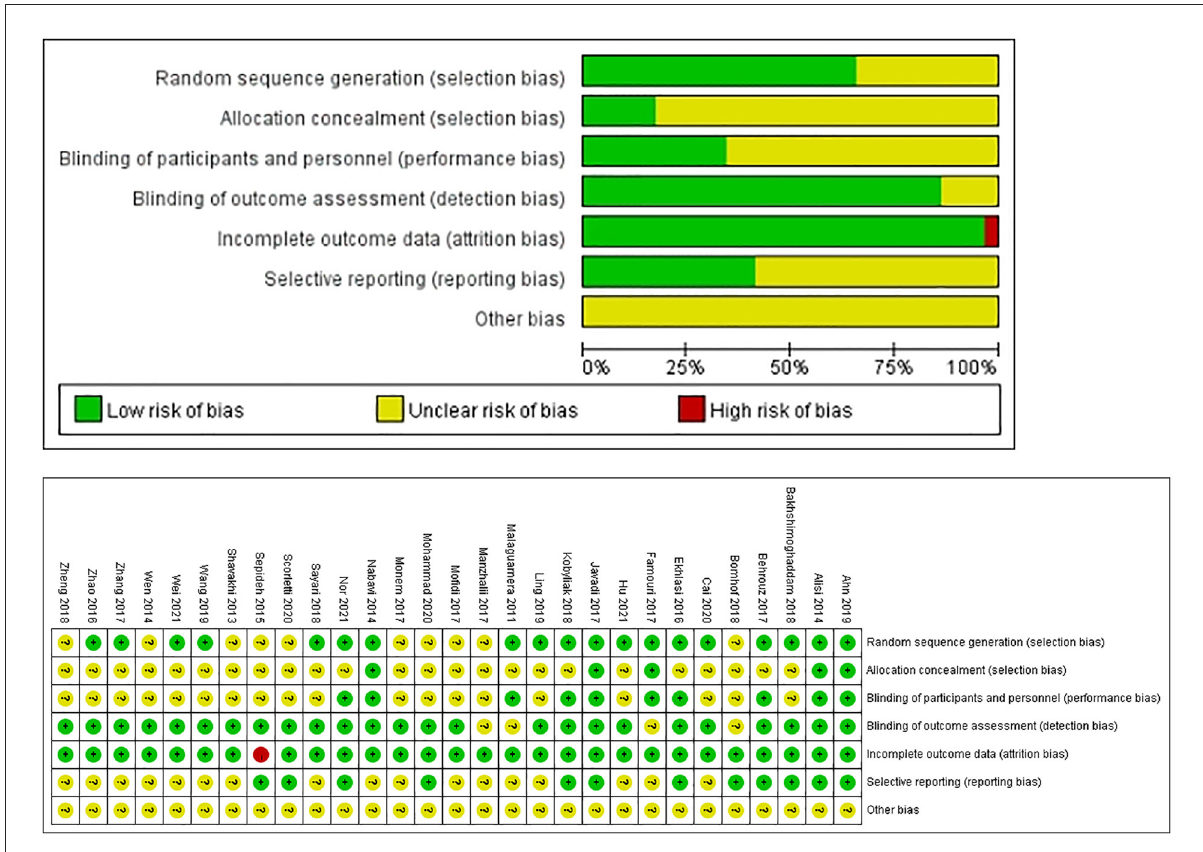
FIGURE2 Risk-of-bias graph.